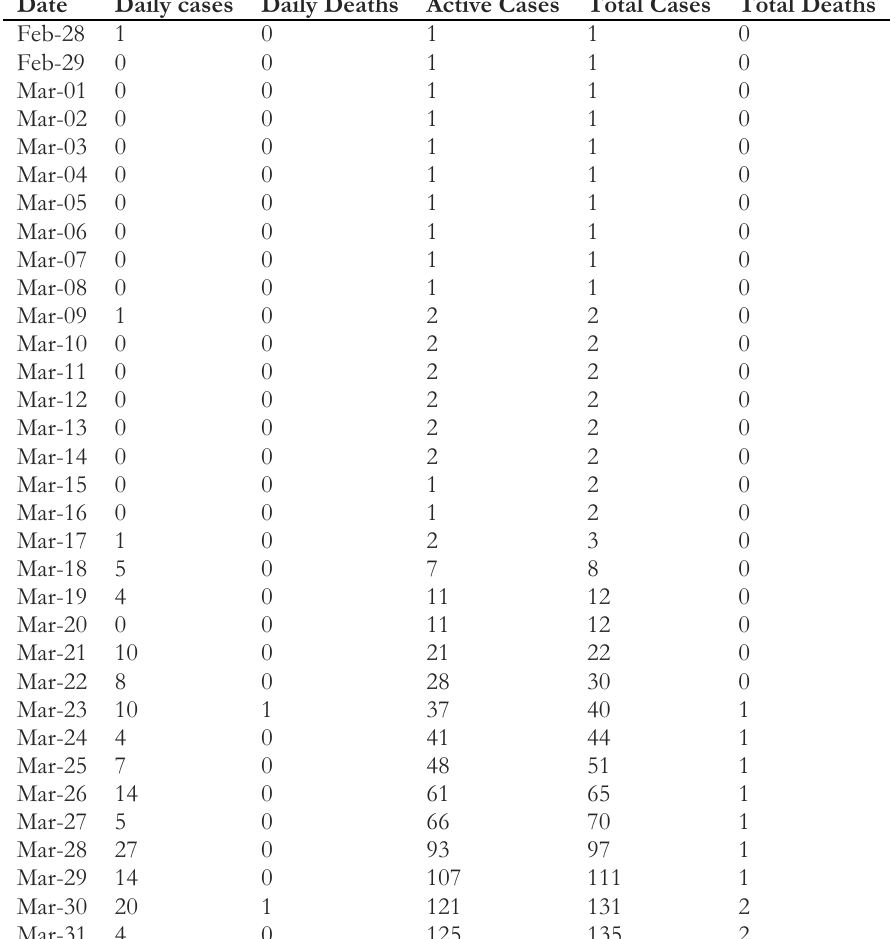
Table 1. Snapshot of COVID-19 cases in Nigeria from 28th February to 31st March,